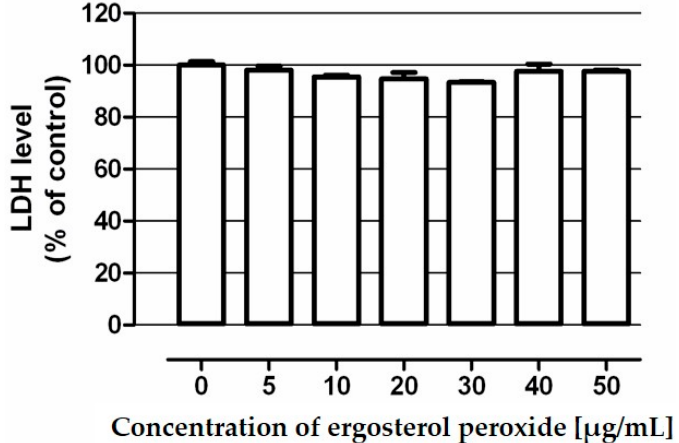
Figure 3. Cytotoxicity of ergosterol peroxide in human colon epithelial cell line CCD 841 CoTr. Cells were exposed to culture medium alone (control) and the medium supplemented with tested compound in concentrations ranging from 5–50 µg/mL for 48 h. Compound cytotoxicity was measured by means of the LDH assay. Results are presented as the mean ± SEM of 4 measurements.